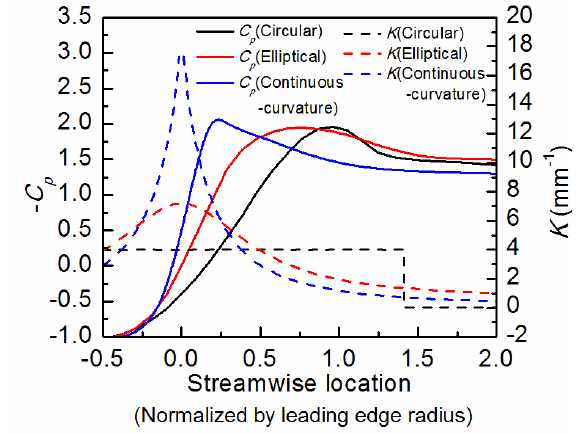
Figure 30. Relationship between suction-surface spike and curvature (α =